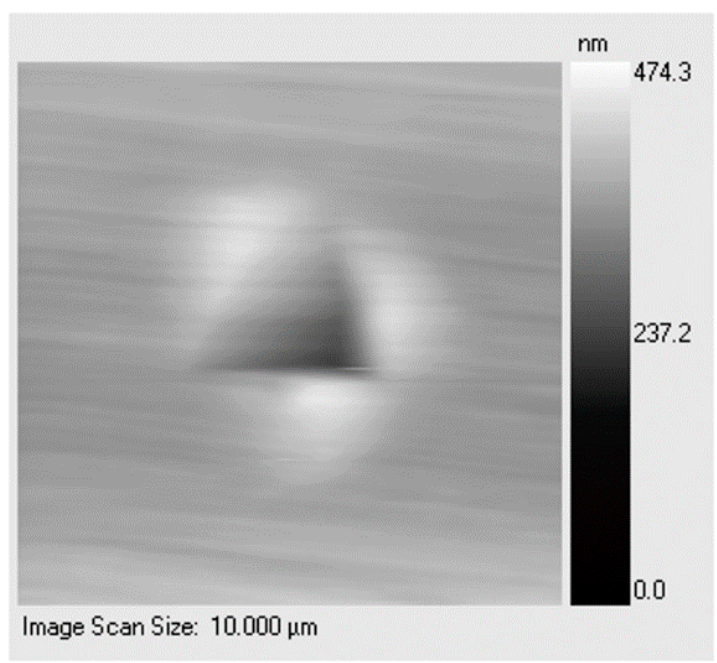
Figure 9. SPI of a pile-up phenomenon that occurred in the H58-DHP Cu. Table 4. Deviation of the Oliver and Pharr analysis generated by pile-up. This was calculated by applying method-1 and method-2 to the H58-DHP Cu.